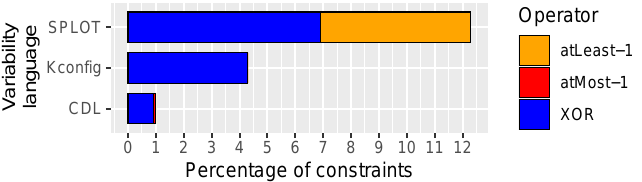
Figure 2. Percentage of grouping constraints that Berger et al. [53] found in 128 real variability